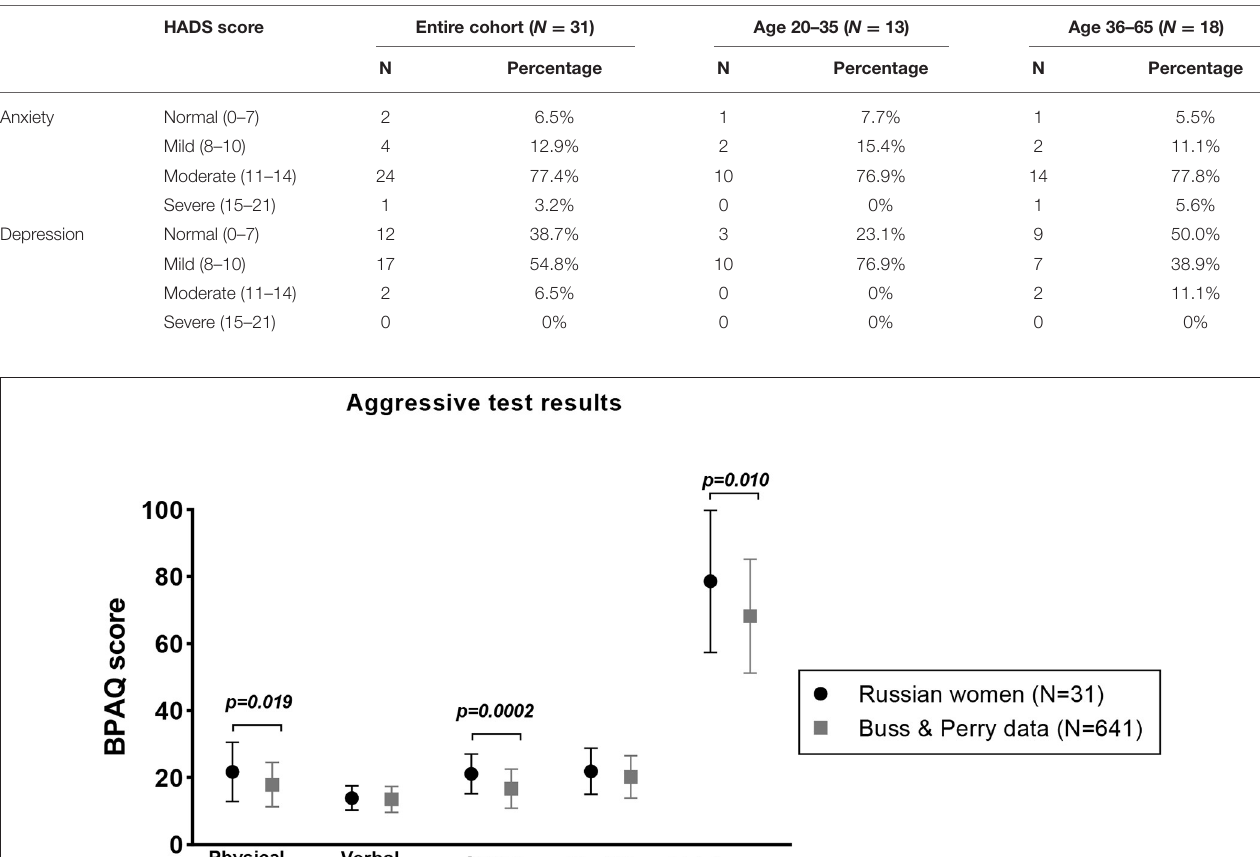
TABLE 1 | Results of the HADS test.